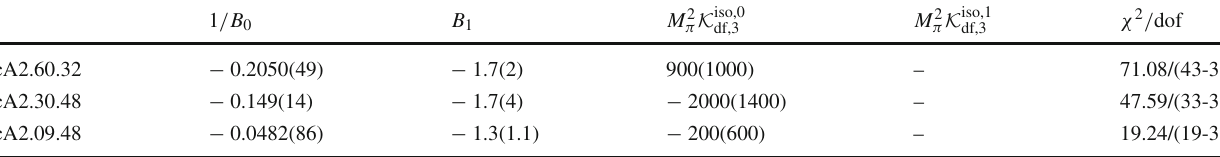
Fig. 10 s - and d -wave phase shift for the ensemble cA2.60.32. For s -wave we use a model that incorporates the Adler-zero, whereas for d -wave we fit to a constant in the region for which we have data. Two points have been omitted in the plot due to the very large errorbars Table 10 Two- and three-pion fits using the Adler-zero form ( z 2 = M 2 π , fixed). Here we assume that K 3,df is given by a constant: K 3,df = K iso,0